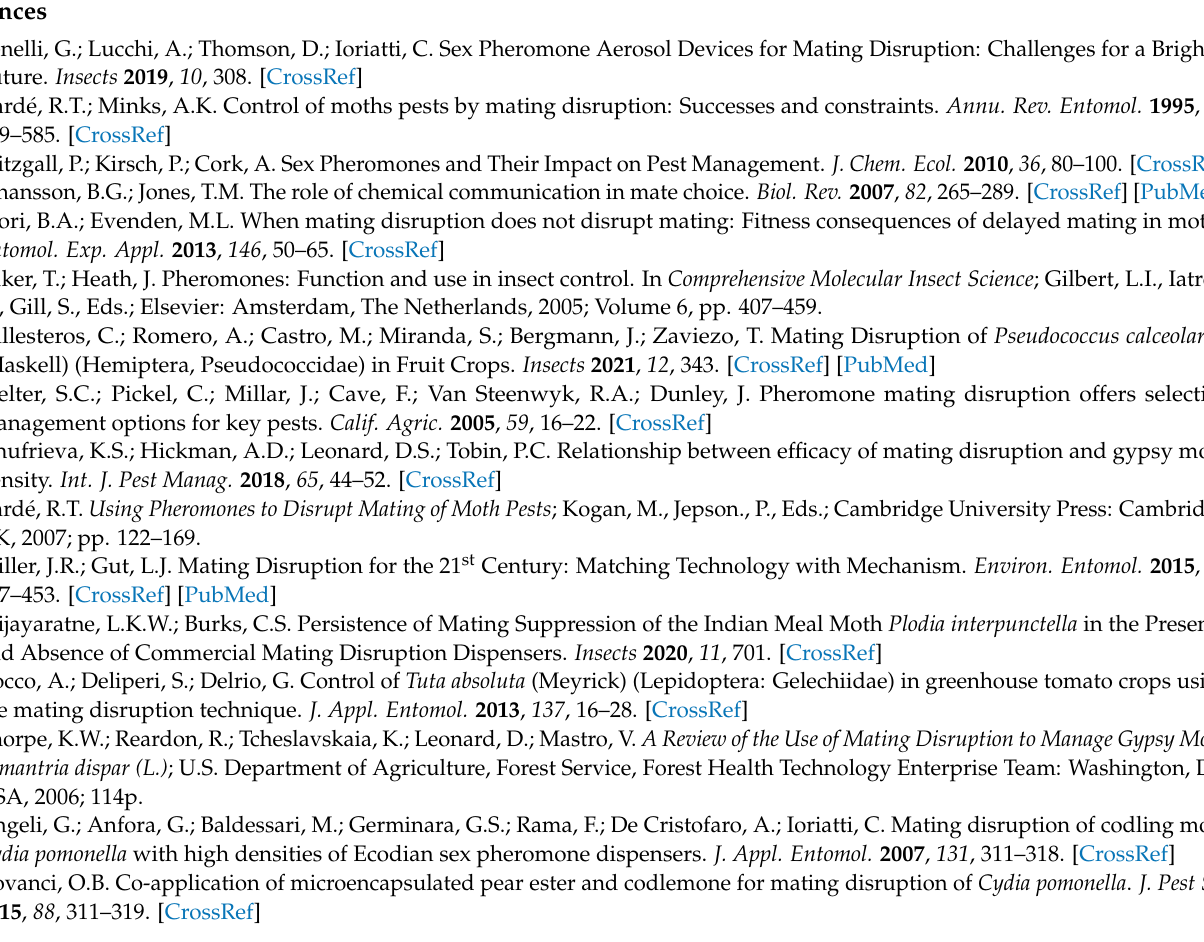
Figure S1: Ecodian ® CT pheromone dispenser applied in chestnut